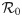
Cryptosporidium dose–response and dynamics with the fixed stochastic R0.Modeled number of infected people under different dose–response relationships, where α is adjusted so that R0*=2 for each simulation. The exponential, exact and approximate beta–Poisson, and Hill-1 functions lie nearly on top of each other, and the Hill-n and lognormal functions have no outbreak.